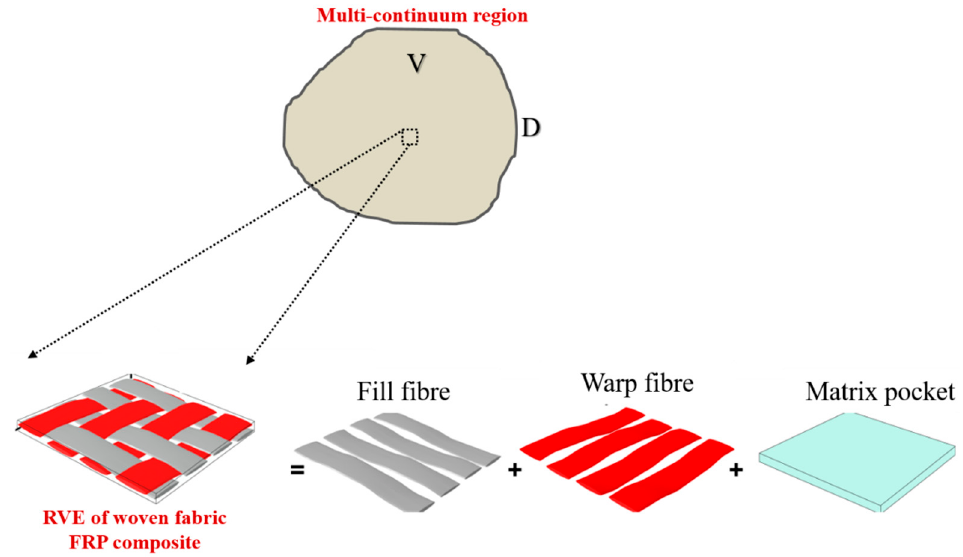
Figure A1. Woven composite material RVE definition in Multi Continuum Theory.